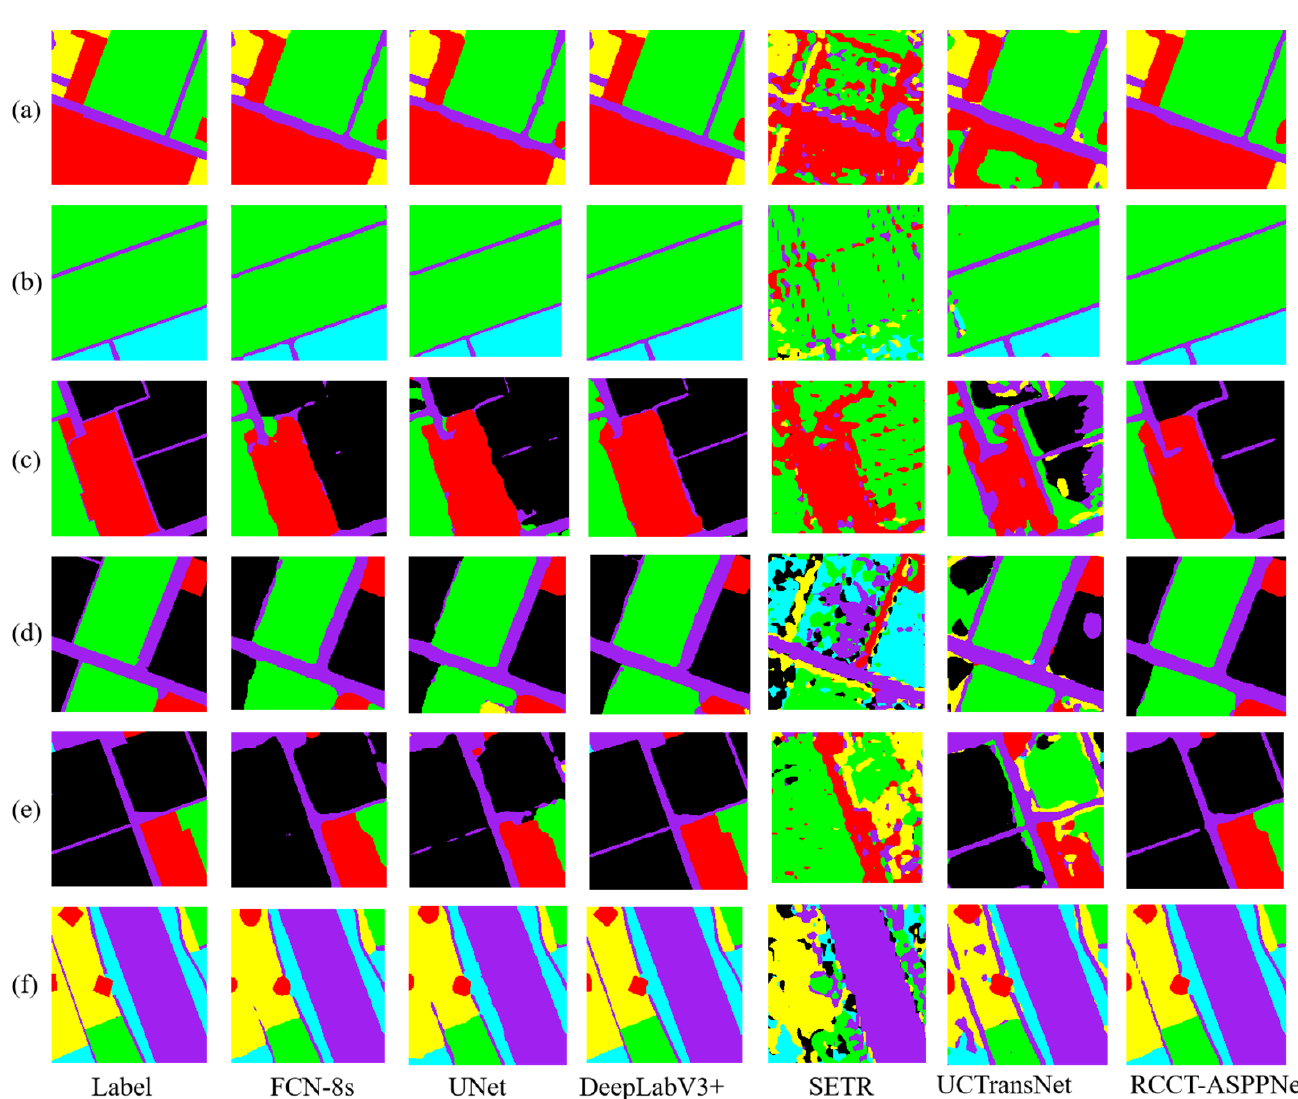
Figure 10. Farmland data prediction results, from left to right, are real labels, FCN, UNet, Deeo- LabV3+, SETR, UCTransNet, and RCCT-ASPPNet, from top to bottom, ( a – f ) are the selected 6 sets of Farmland test images.